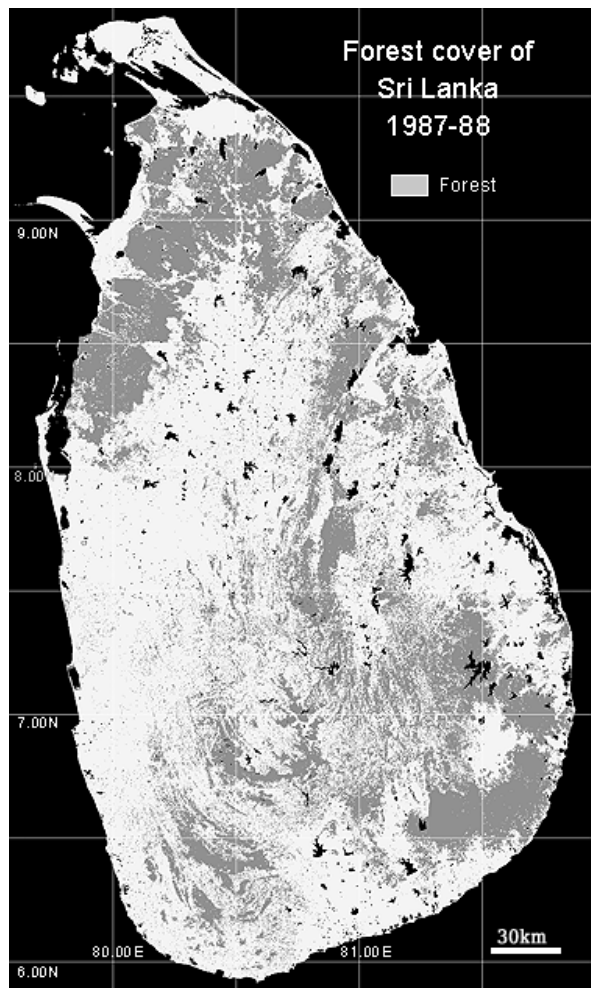
Figure 4. Forest cover of 1988.